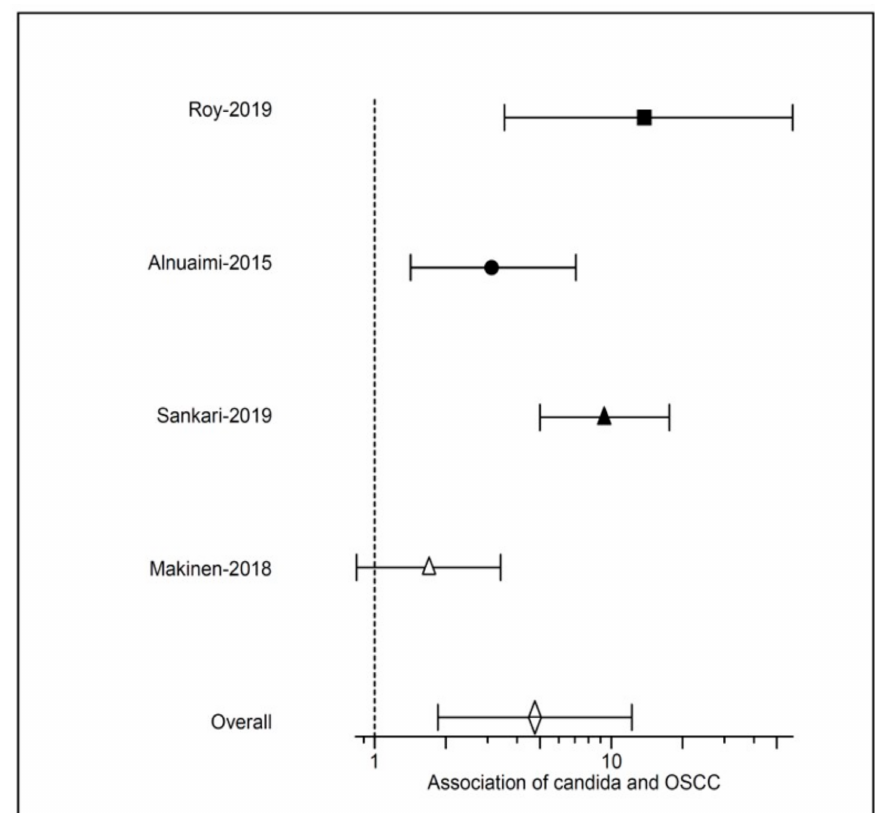
Figure 2. Forest plot summarizing the results of the meta-analysis for Candida and